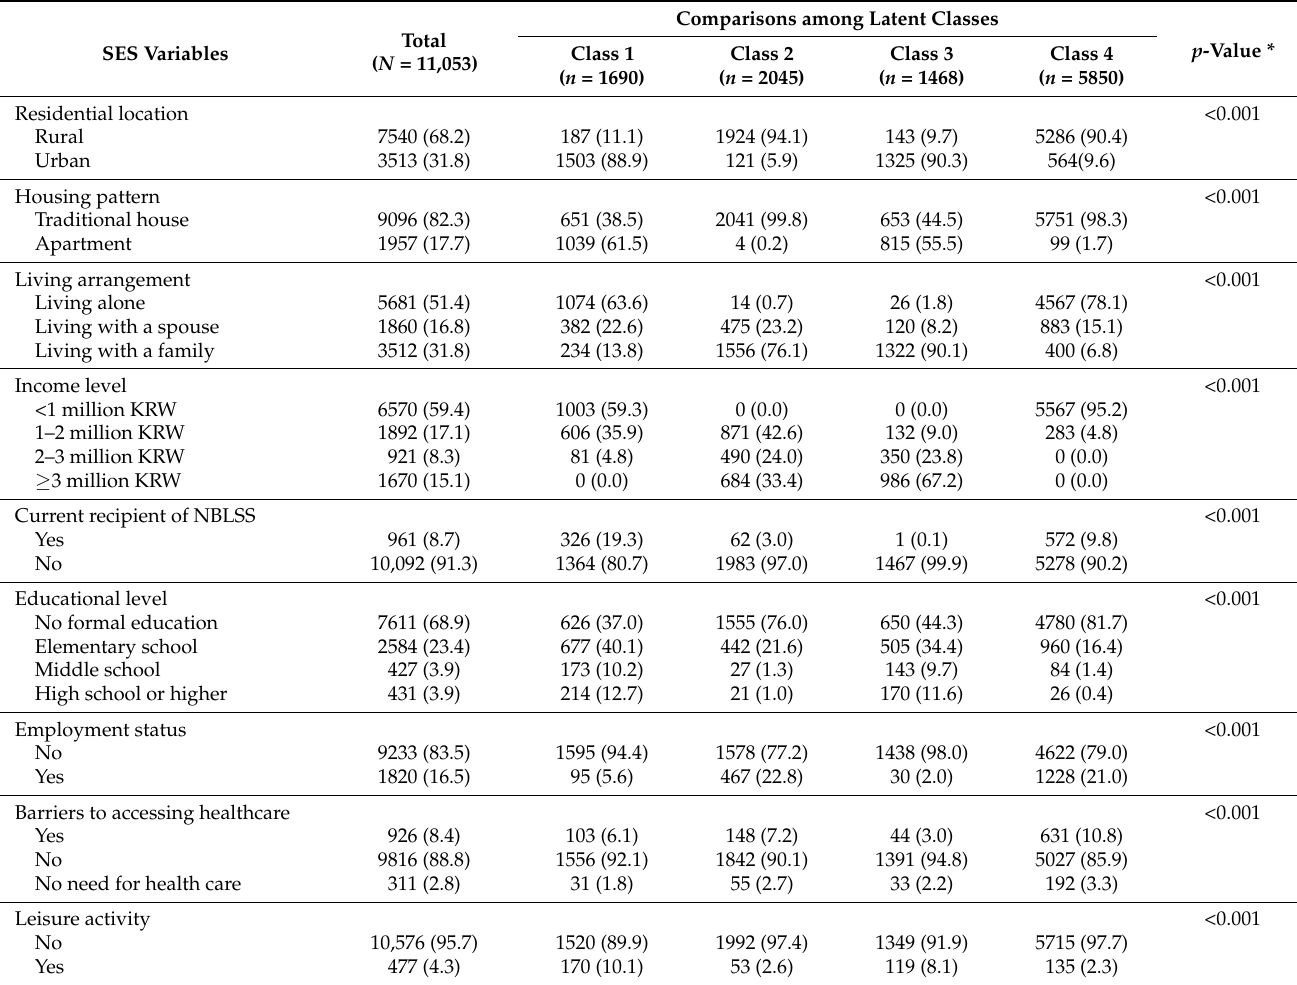
Table 2. Distribution of SES risks in the 4-class